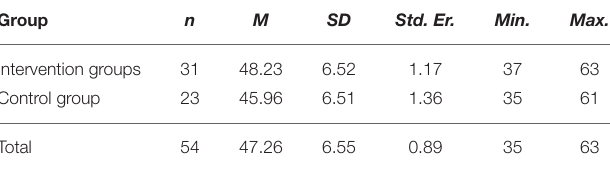
TABLE 2 | Descriptive data of academic procrastination scores at T1. Group n M SD Std. Er. Min.